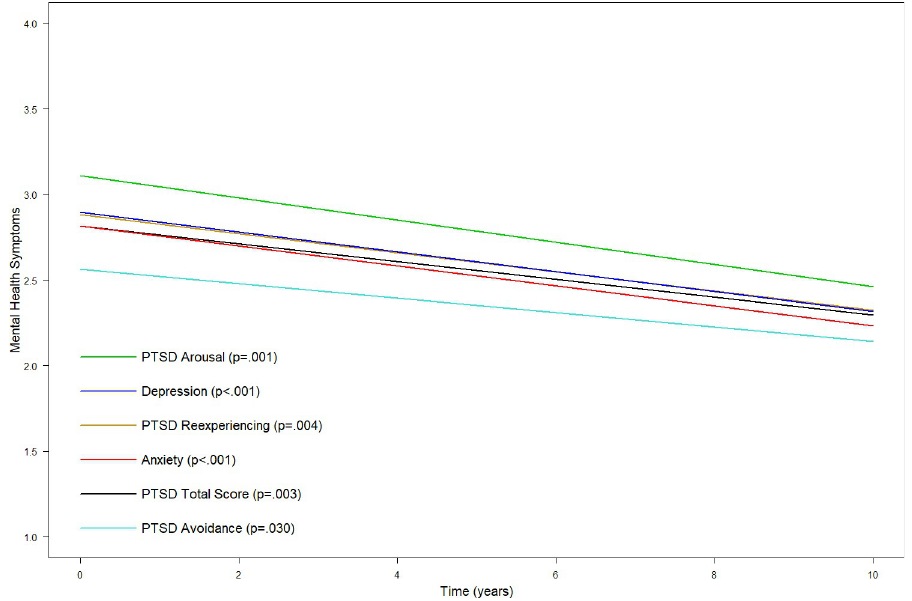
Fig 1. Improvement in mental health symptoms over time. All reductions in symptoms were significant. Symptoms of PTSD were measured by the Harvard Trauma Questionnaire (HTQ Part IV) [63]. Anxiety and Depression were measured by the Hopkins Symptom Checklist (HSCL-25) [63]. The plot illustrates the trajectories over 10 years from study inclusion/treatment start.